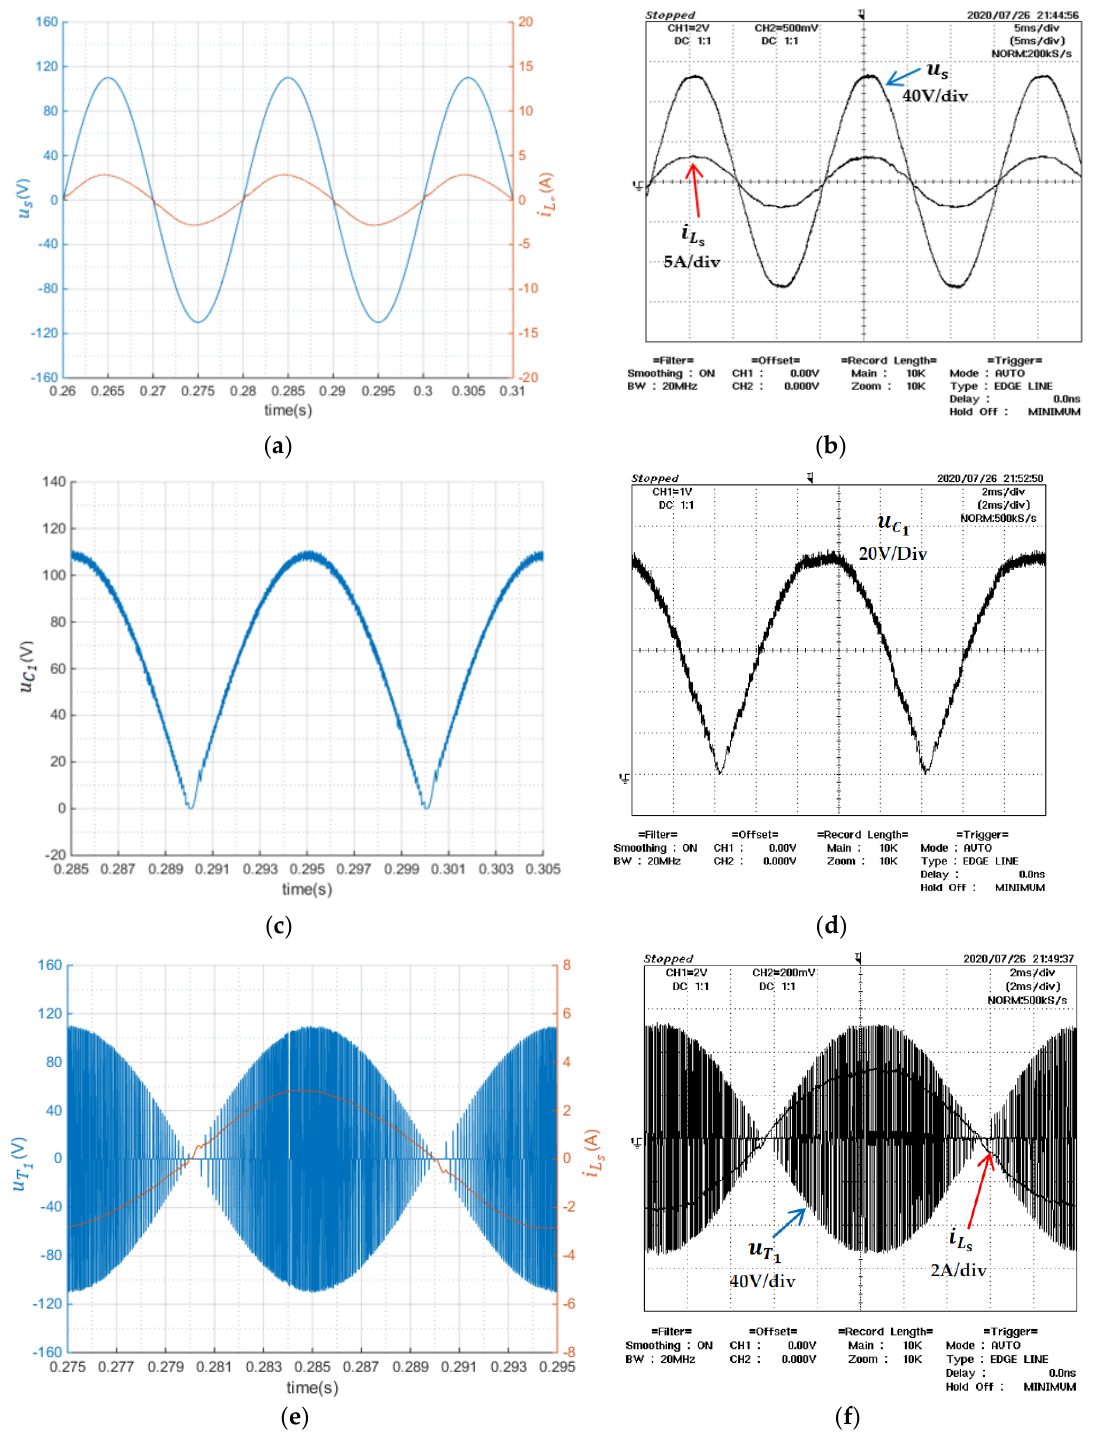
Figure 10. Waveforms at primary side of the AC-DC converter: ( a ) simulation results of voltage u s and current i L ; ( b ) experimental results of voltage u s and current i L S voltage u C ; ( d ) experimental results of voltage u C ; ( e ) simulation results of voltage u T 1 1 ( f ) experimental results of voltage u T and current i L S 1